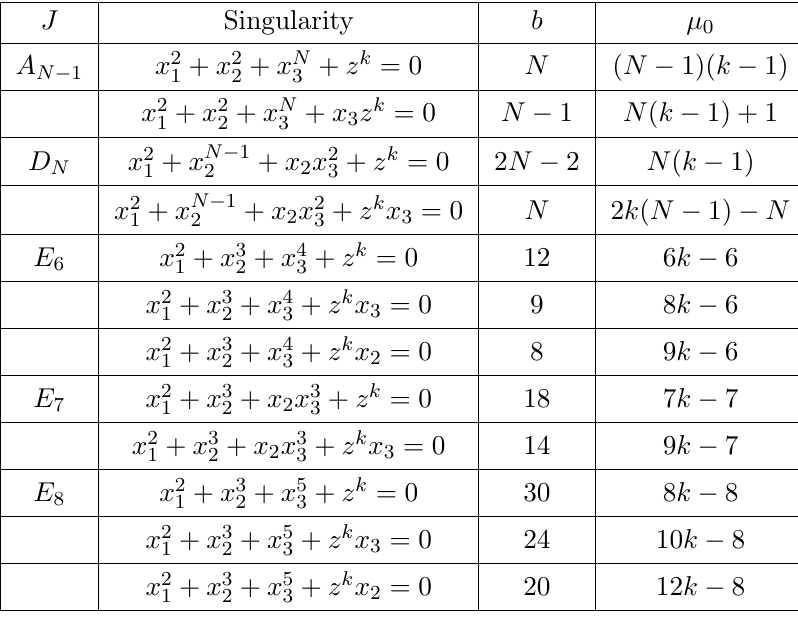
Table 1 . 3-fold singularities corresponding to our irregular punctures [23], where (cid:22) 0 is the dimension of charge lattice. When b = h with h the dual Coxeter number, such theories are also called ( J; A k (cid:0) 1 ) which were (cid:12)rst studied in [33].